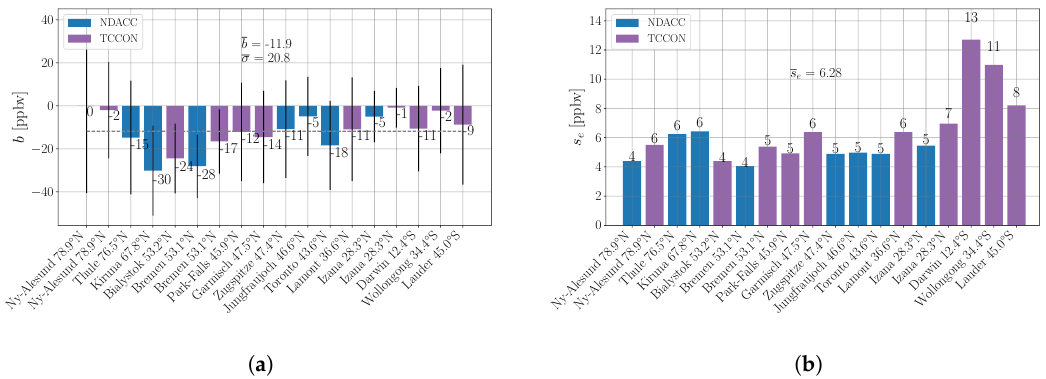
Figure 9. Same illustration as in Figure 7 and 8 but weighted inverse to the distance squared. ( a ) Global monthly-mean bias b and respective standard error σ ; ( b ) The global standard error of the mean biases s e is the average of all standard errors of the means. Table 3. The respective biases b (bold) and standard errors s e separated for NDACC and TCCON. The NDACC reveals a significant bias and standard error of the means. This is also true if linear ( r − 1 ) and quadratic ( r − 2 ) inverse distance weighting is applied. With respect to the TCCON, the bias is less significant and closer to the magnitude of the standard error. ppbv: parts per billion in volume.